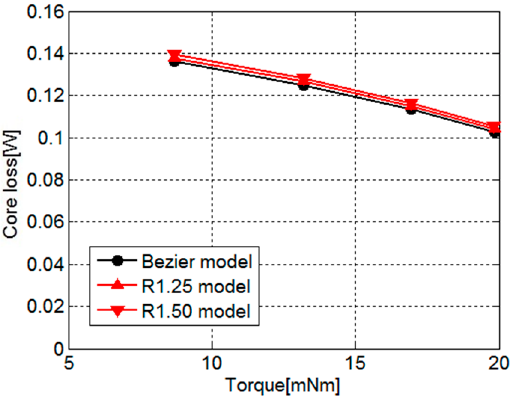
Figure 13. Core loss for torque of the Bezier model, R1.25 model, and R1.50 model.